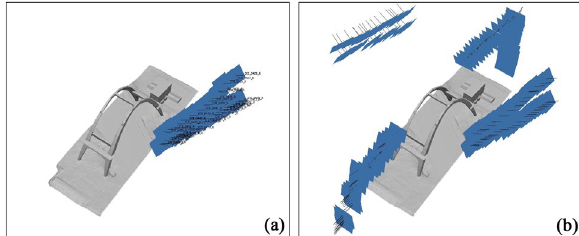
Figure 9 . (a) Oriented TIR cameras following the first workflow. (b) Oriented cameras following the second workflow). Figure 8 . Module of the school façade: 3D mesh derived from visible data, with texture derived from (a) visible data and (b) thermal data.